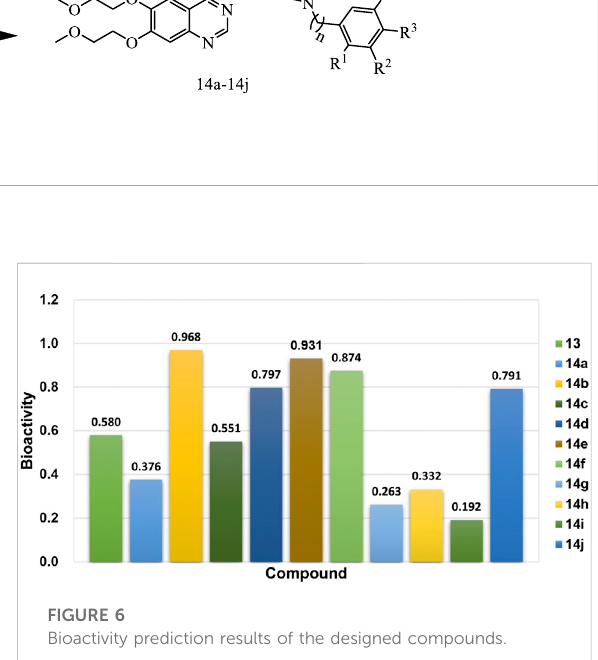
FIGURE 6 Bioactivity prediction results of the designed compounds.